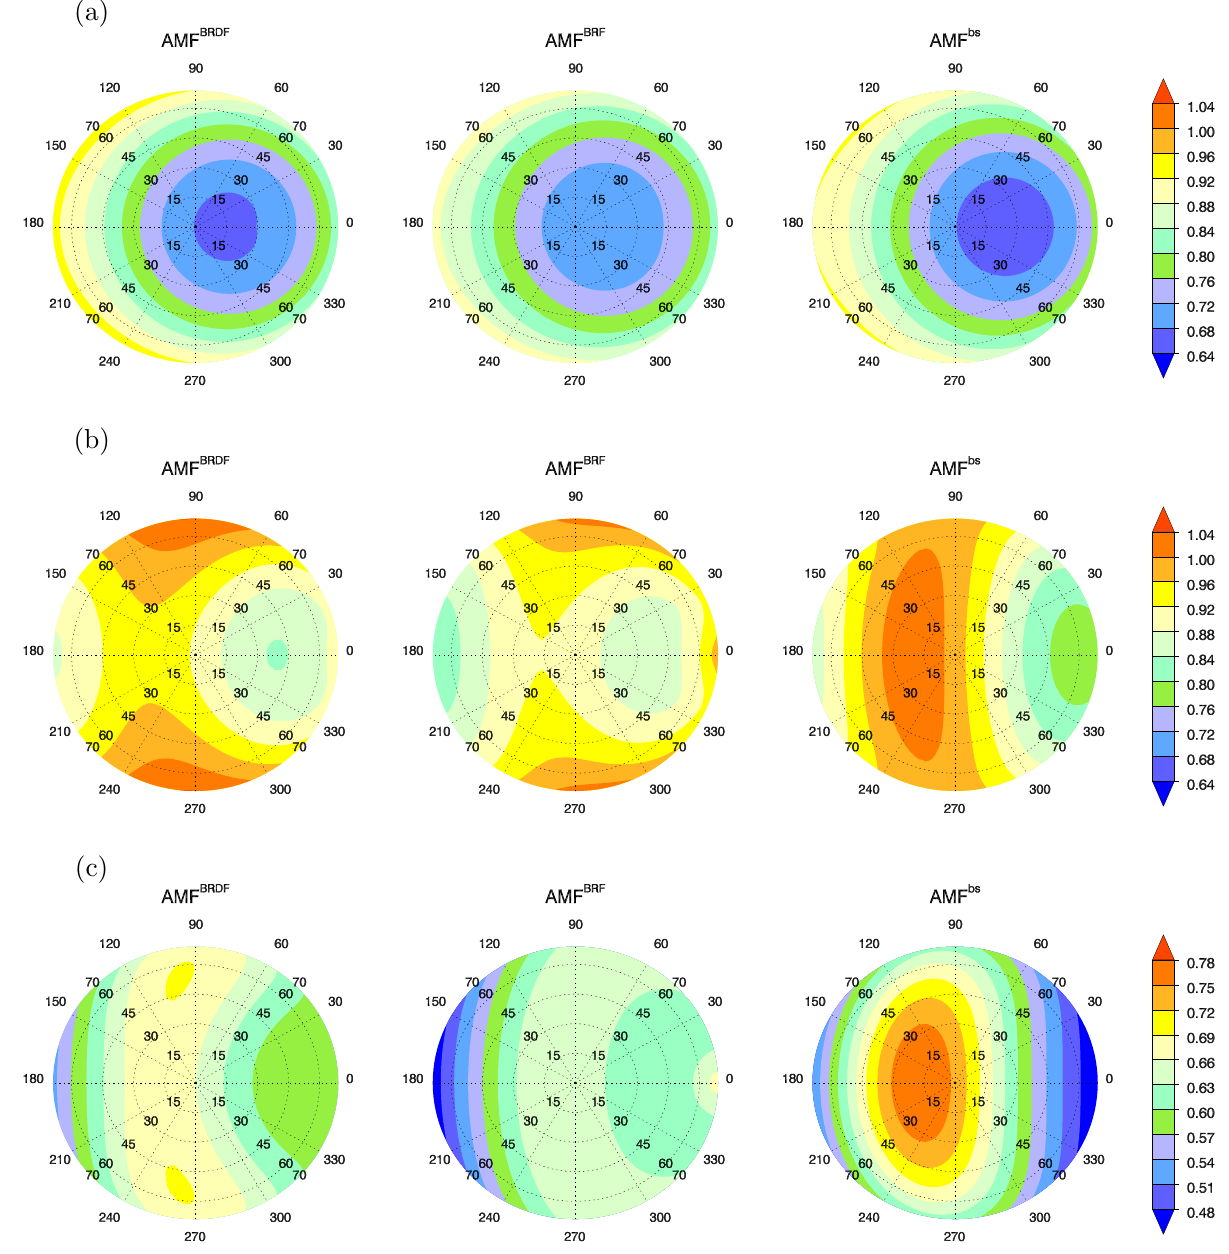
Fig. 8. Polar plots of AMF BRDF , AMF BRF and AMF bs for (a) case A1 in July, (b) case A2b in November and (c) case A2a in November (see Table 1).